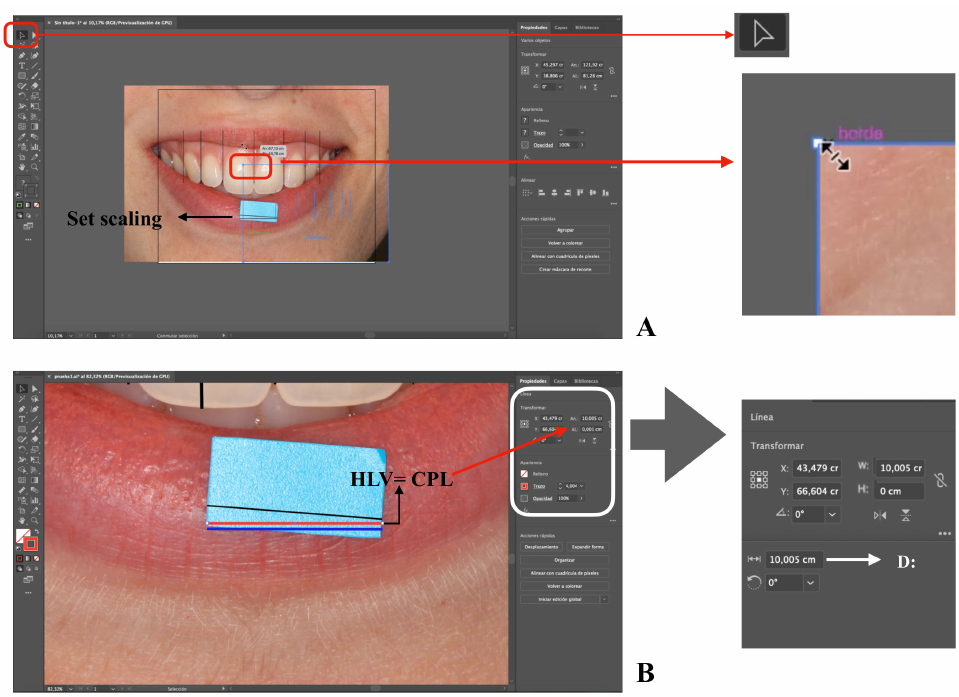
Figure 4. Screenshots of the sample image with the different steps of the protocol. LOV: line on the verifying witness. HLV: horizontal line on the verifying tab for scale. CPL: calibrated parallel horizontal line. D: distance. Screenshots of the sample image with the different steps of the protocol ( A , B ).